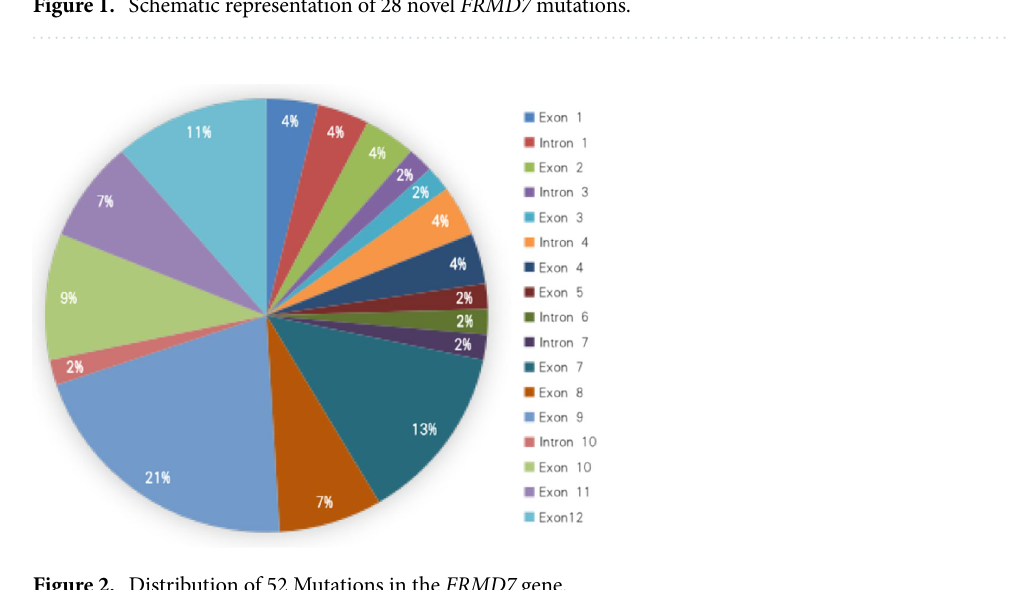
Figure 2. Distribution of 52 Mutations in the FRMD7